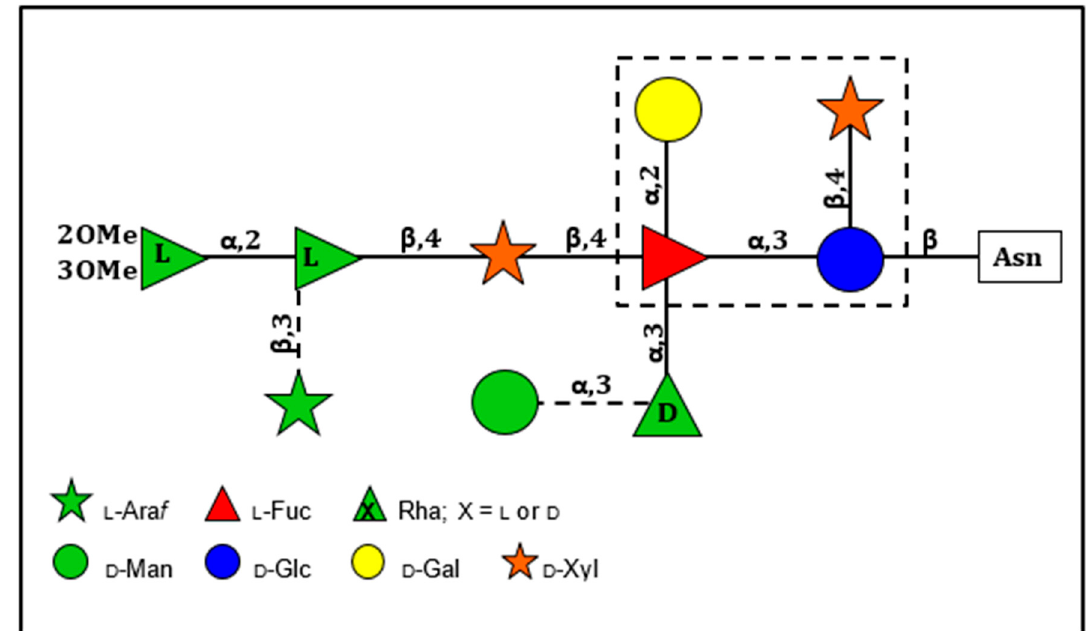
Figure 3. Structure of the glycan attached to the chlorovirus PBCV-1 major capsid protein (Vp54). Monosaccharides (mannose and arabinose) connected by dashed lines are not stoichoiometric substituents. The monosaccharides that are boxed are conserved in the glycans from all the chloroviruses. The figure is slightly modified from a figure from De Castro et al. [58].